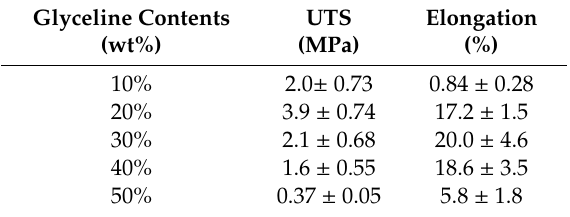
Table 2. Tensile strength and elongation for soy samples with di ff erent DES